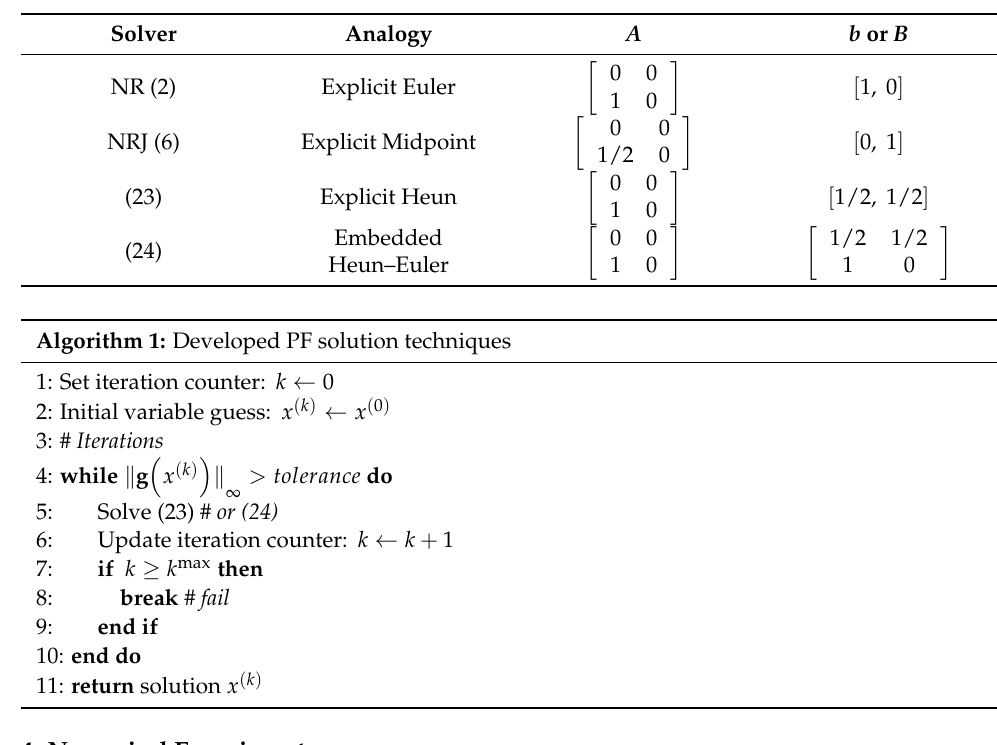
Table 1. Definition of some PF solvers based on the developed solution paradigms using ma- trix/vector notation.